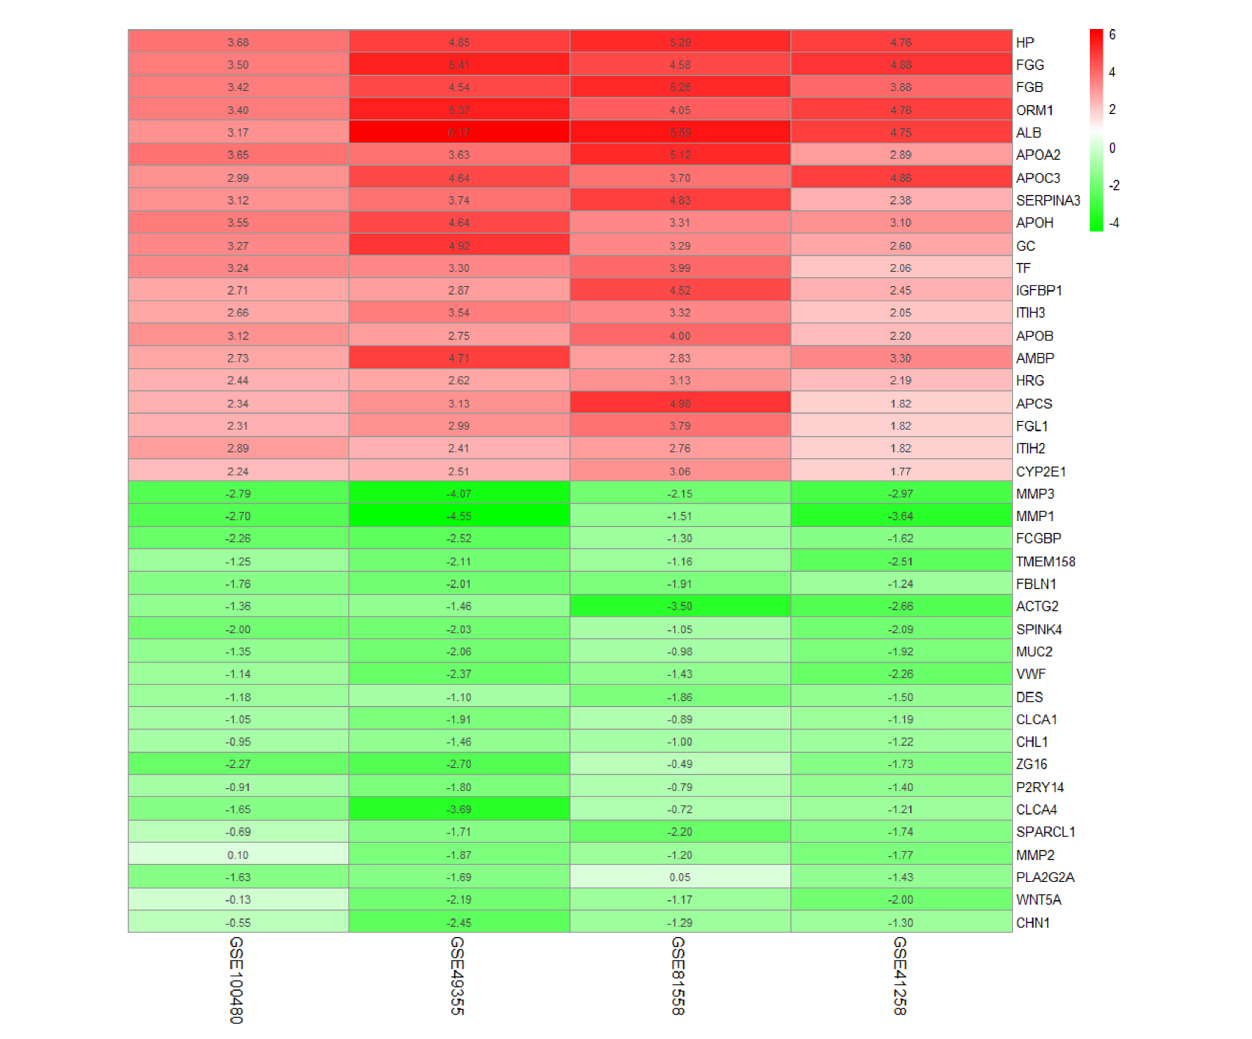
FIGURE 2 | Common DEGs identi fi ed by robust rank aggregation algorithm; heatmap shows top 20 of up- and downregulated genes. From green to red, the expression value of the gene in four GEO series gradually increases. The GEO series are presented on the x-axis and gene expression value on the